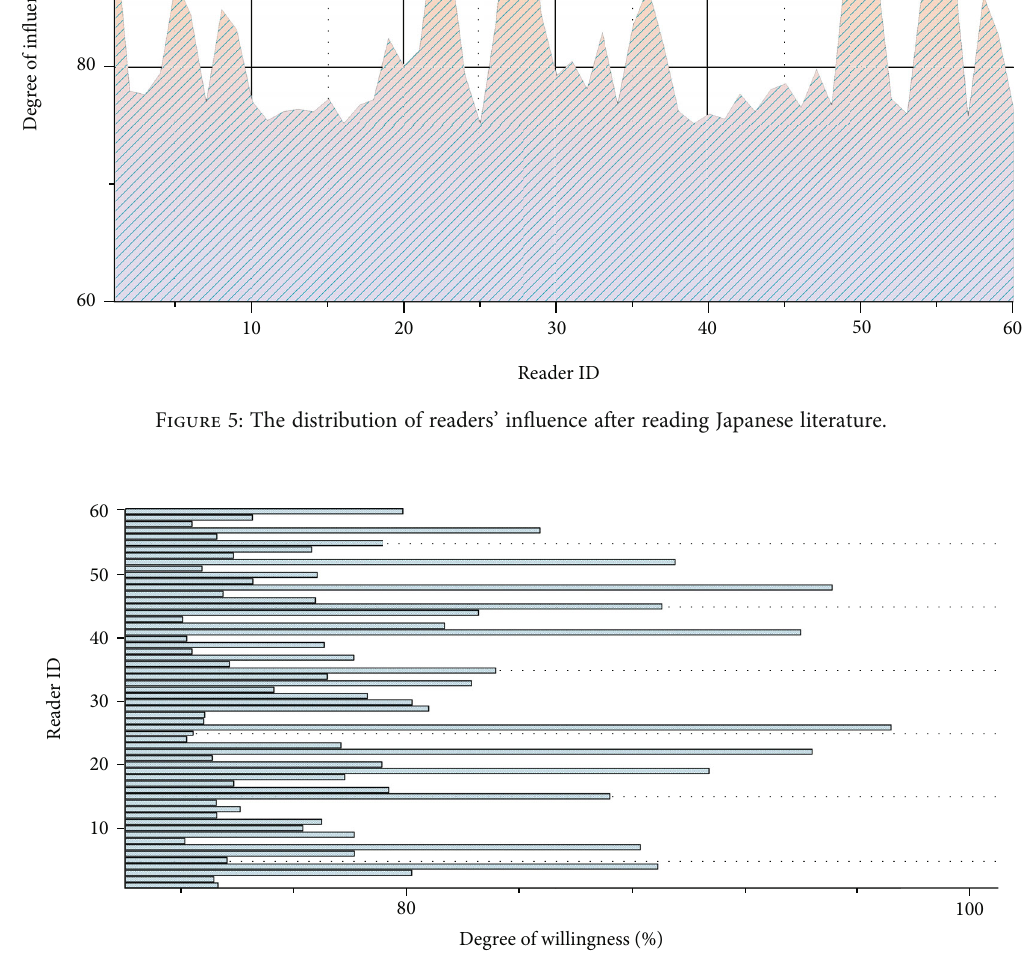
Figure 6: The distribution of readers ’ willingness to continue reading and purchase Japanese literature. Table 2: Chi-square test of readers ’ cognition of Japanese literature and their preference for Japanese